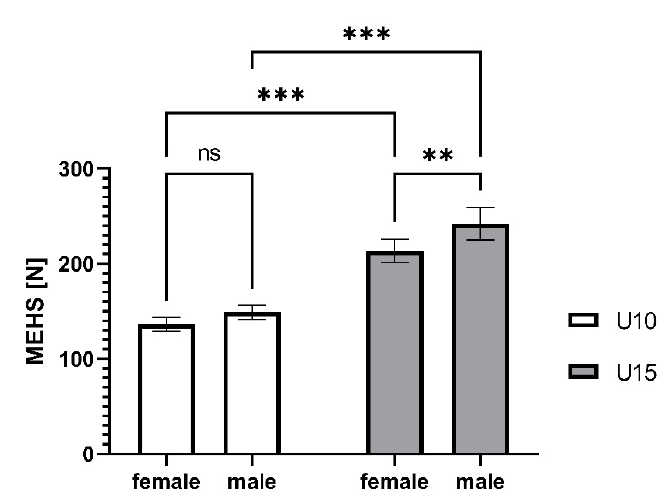
Figure 1. Maximal eccentric hamstring strength (MEHS) separated by age group and sex. Data are expressed as the mean and 95%CI. Level of significance based on a two-way ANOVA: ns not signif- icant; ** p < 0.01; *** p < 0.001.